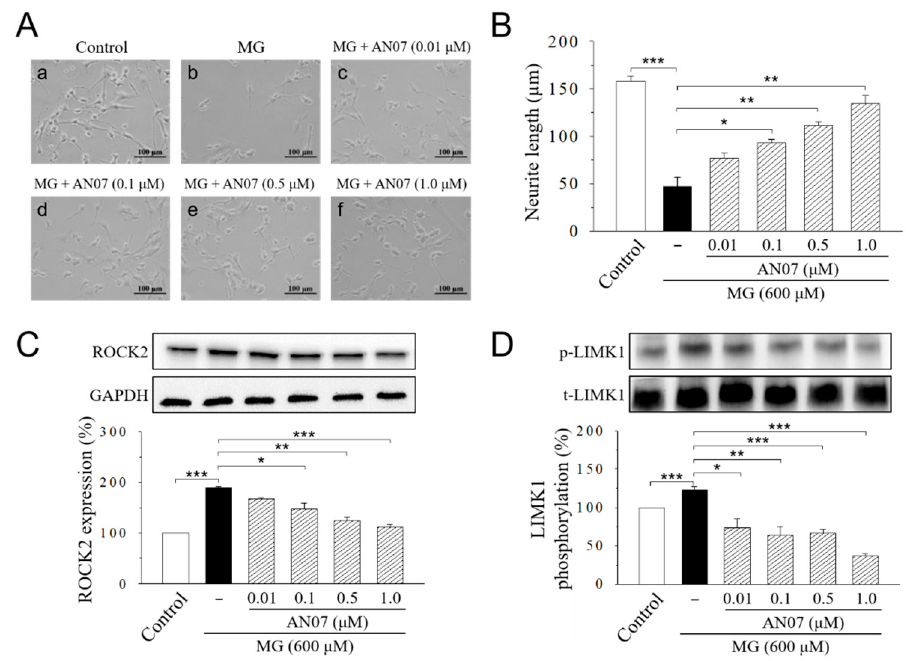
Figure 6. AN07 attenuates methylglyoxal (MG)-induced neurite damage in SH-SY5Y cells. ( A , B ) Representative images showed the protective e ff ect of AN07 on MG-induced reduction in neurite outgrowth in SH-SY5Y cells. Cells were incubated with retinoic acid (10 µ M) for five days to induce di ff erentiation. Di ff erentiated SH-SY5Y cells were pre-treated with AN07 (0.01–1.0 µ M) for 1 h and then exposed to 600 µ M MG for another 24 h. Neurites were imaged with a phase-contrast microscope ( A ), and the neurite length of cells ( B ) was calculated using the ImageJ software. Scale bar, 100 µ m. Columns, mean ± S.E.M. from at least 30 cells of three independent experiments. ( C , D ) AN07 down-regulates Rho-associated protein kinase 2 (ROCK2) expression and LIM kinase 1 (LIMK1) phosphorylation in MG-treated SH-SY5Y cells. Upper panels, representative immunoblots. Lower panels, densitometry analyses of the relative ratio of ROCK2 / glyceraldehyde-3-phosphate dehydrogenase (GAPDH) protein and phosphorylated-LIMK1 / total-LIMK1 (t-LIMK1), which is represented as percentages of the control group. Columns, mean ± S.E.M. from at least three independent experiments. * p < 0.05, ** p < 0.01, *** p < 0.001.